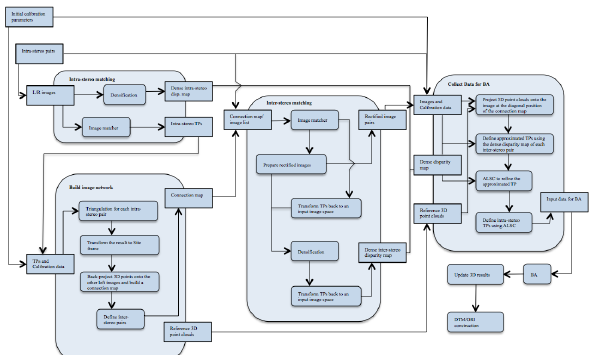
Figure 4. Flow diagram of implemented wide baseline stereo reconstruction processing